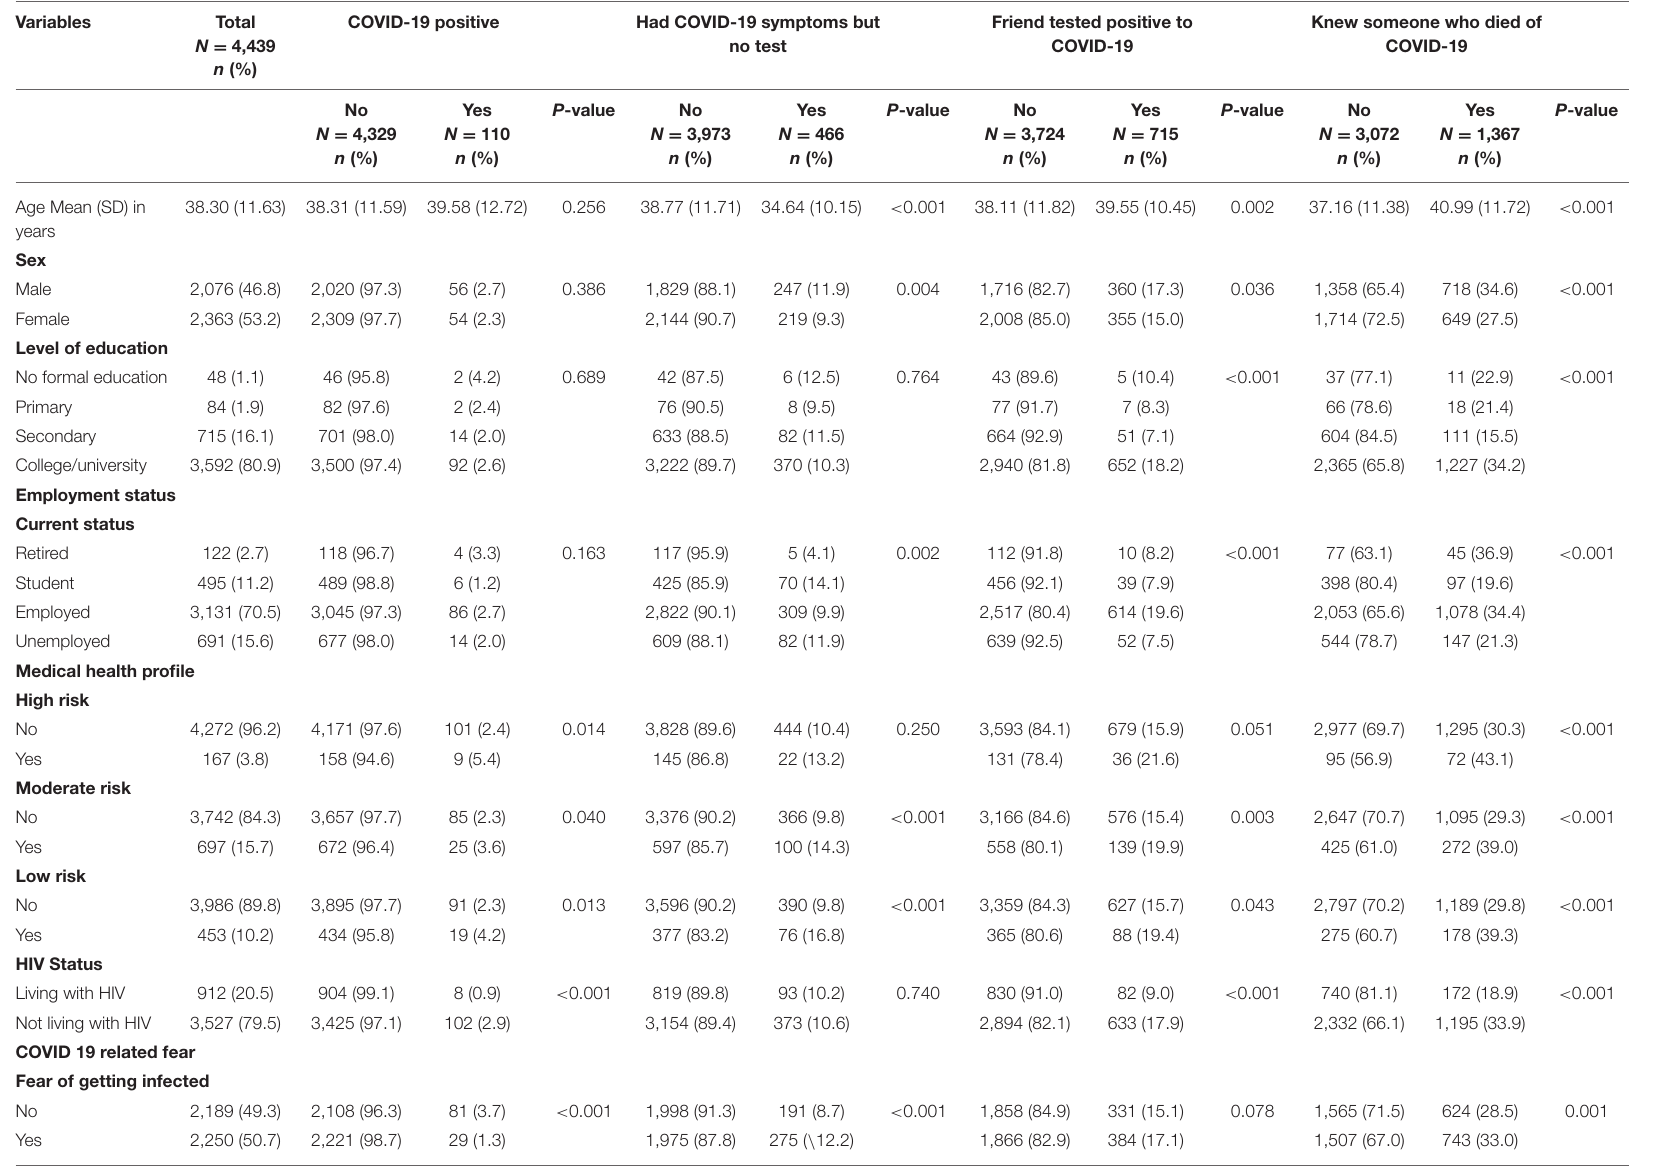
TABLE 1 | Factors associated with COVID-19 status by adults in Nigeria ( N = 4,439). Variables COVID-19 positive Had COVID-19 symptoms but